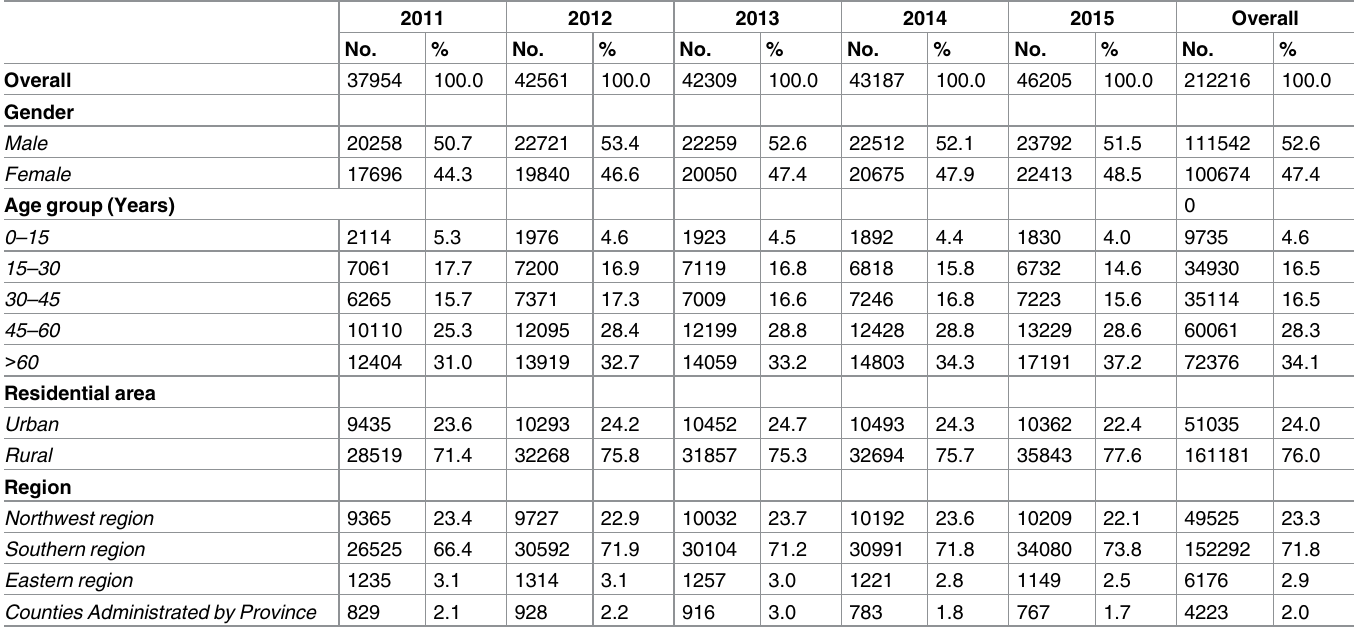
Table 1. Distribution of the yearly reported pulmonary tuberculosis cases in Xinjiang Uygur Autonomous Region, China,